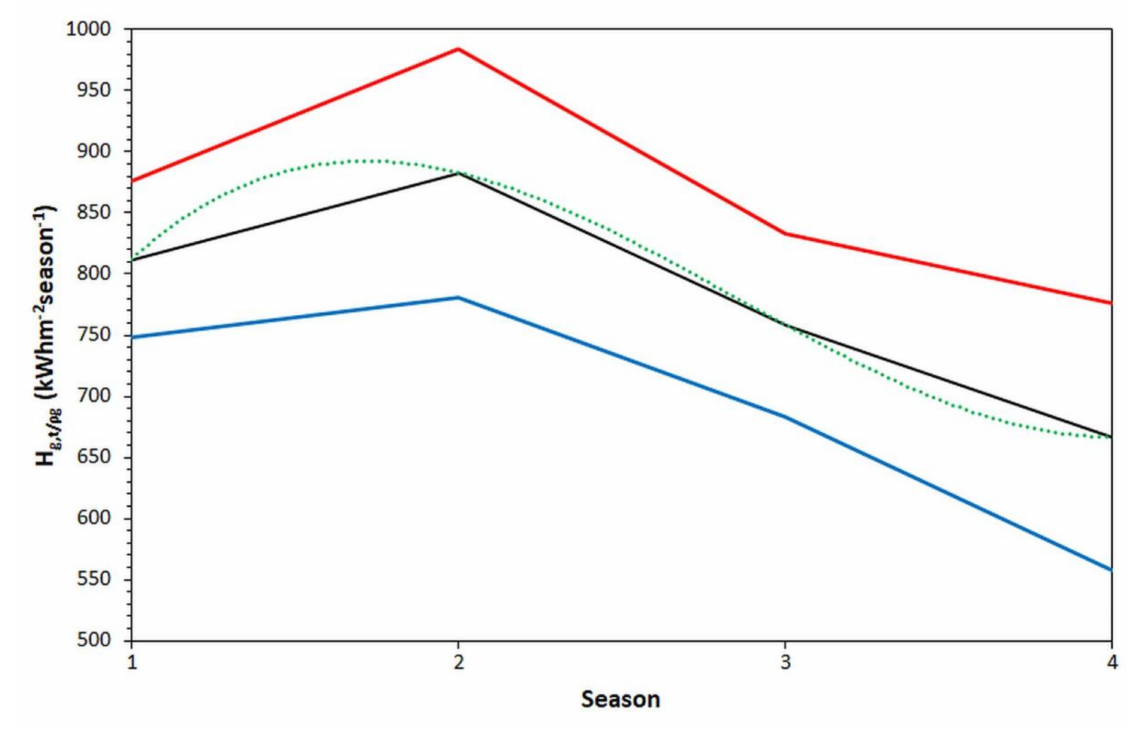
Figure 8. Seasonal variation of H g,t/ ρ g in Saudi Arabia. The black line represents the seasonal mean. The red line refers to the mean + 1 σ curve, and the blue one to the mean − 1 σ curve, under all-sky conditions. All H g,t/ ρ g values were averaged over all 82 sites and over each season in the period 2005–2016. The green dotted line refers to the best-fit curve to the mean one. The numbers 1–4 in the x -axis refer to the seasons in the sequence spring to